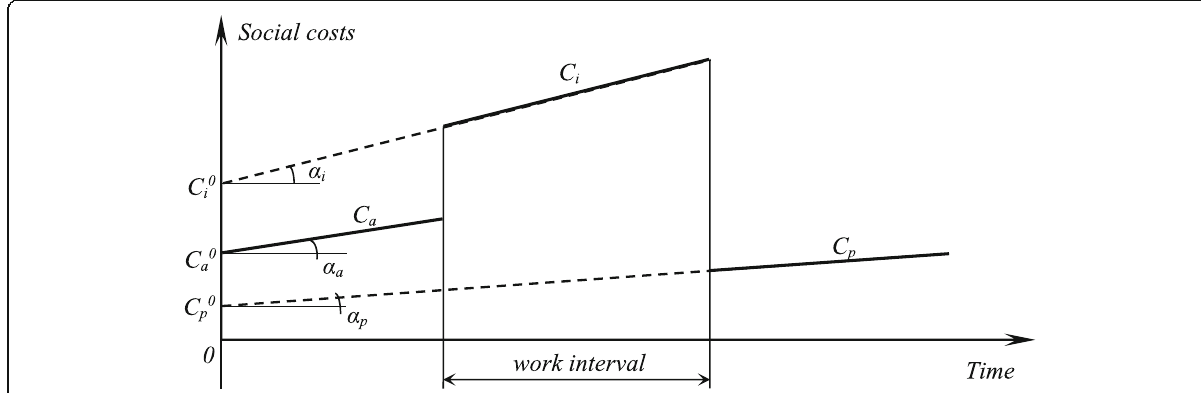
Fig. 5 Social costs: before the beginning of the work (C a ), during the work (C i ) and after the completion of the work (C p )